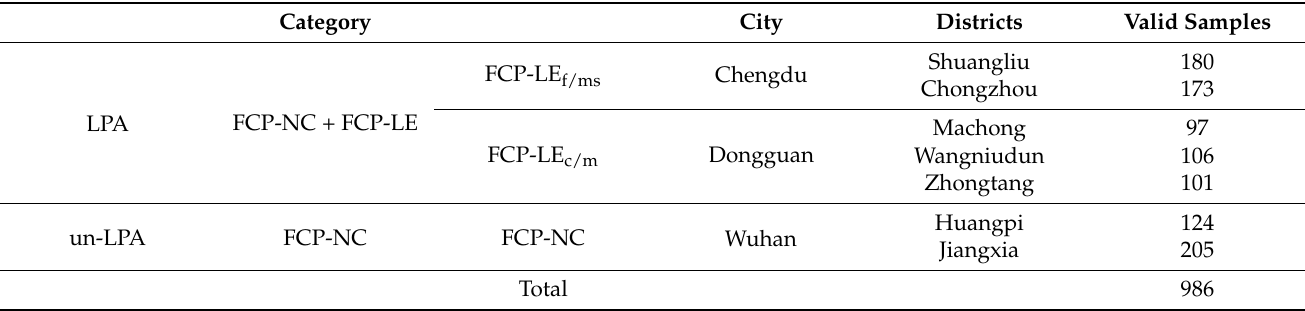
Table 2. Comparison of FCP-LE: Chengdu vs.